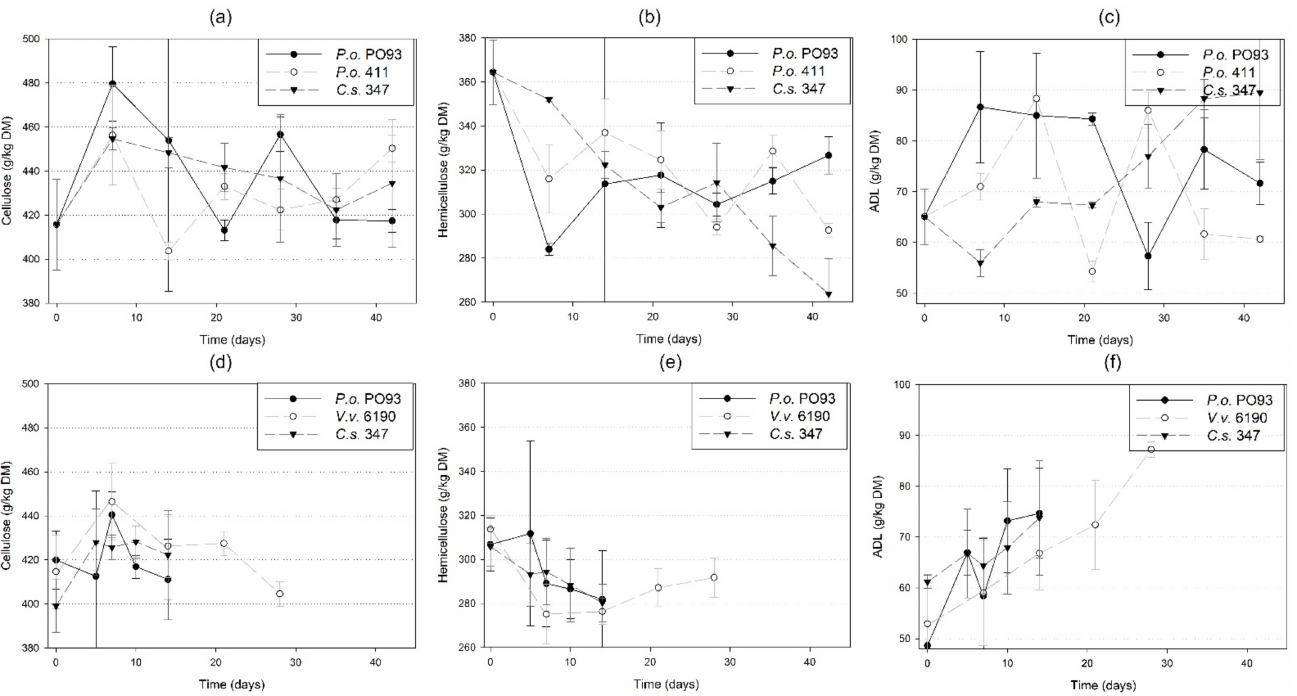
Figure 5. Cellulose, hemicellulose, and ADL concentrations in drained ( a – c ) and remoistened ( d – f ) straw treatments. P.o. — Pleurotus ostreatus ; C.s. — Ceriporiopsis subvermispora ; V.v. — Volvariella volvacea . Error bars indicate the standard deviation